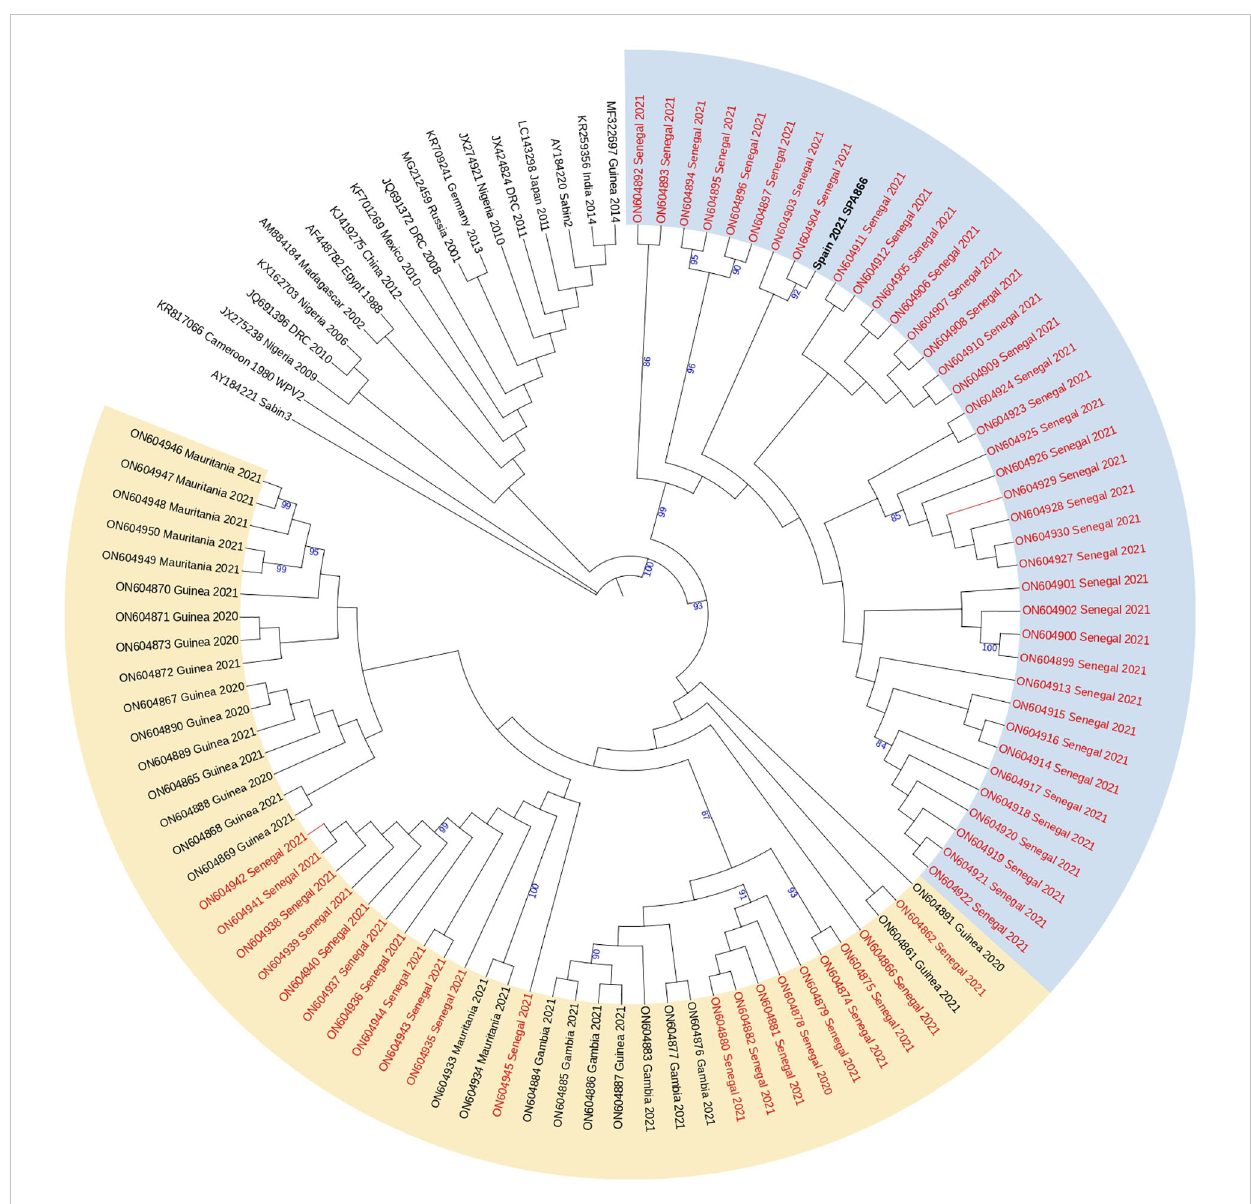
FIGURE 2 Phylogenetic tree of the complete VP1 coding sequences of VDPV2 study strain SPA866 and 104 sequences from previously described VDPV2 strains extracted from GenBank. The neighbor-joining tree was constructed using MEGA 10.0. Distances were computed using the Kimura 2- parameter model after excluding positions containing gaps and missing data from the alignments. The robustness of the nodes was tested by 1,000 bootstrap replications. Only bootstrap support values above 80% are shown in branch nodes. The scale bar represents nt substitutions per site. The tree is annotated with the classi fi cation proposed by Faye et al. for cVDPVs circulating in Senegal since their fi rst introduction in 2020 (clade 1 in yellow and clade 2 in blue). Strains from Senegal are marked in red for clarity. The study strain is marked in bold black. The Sabin-3 poliovirus sequence was introduced as an